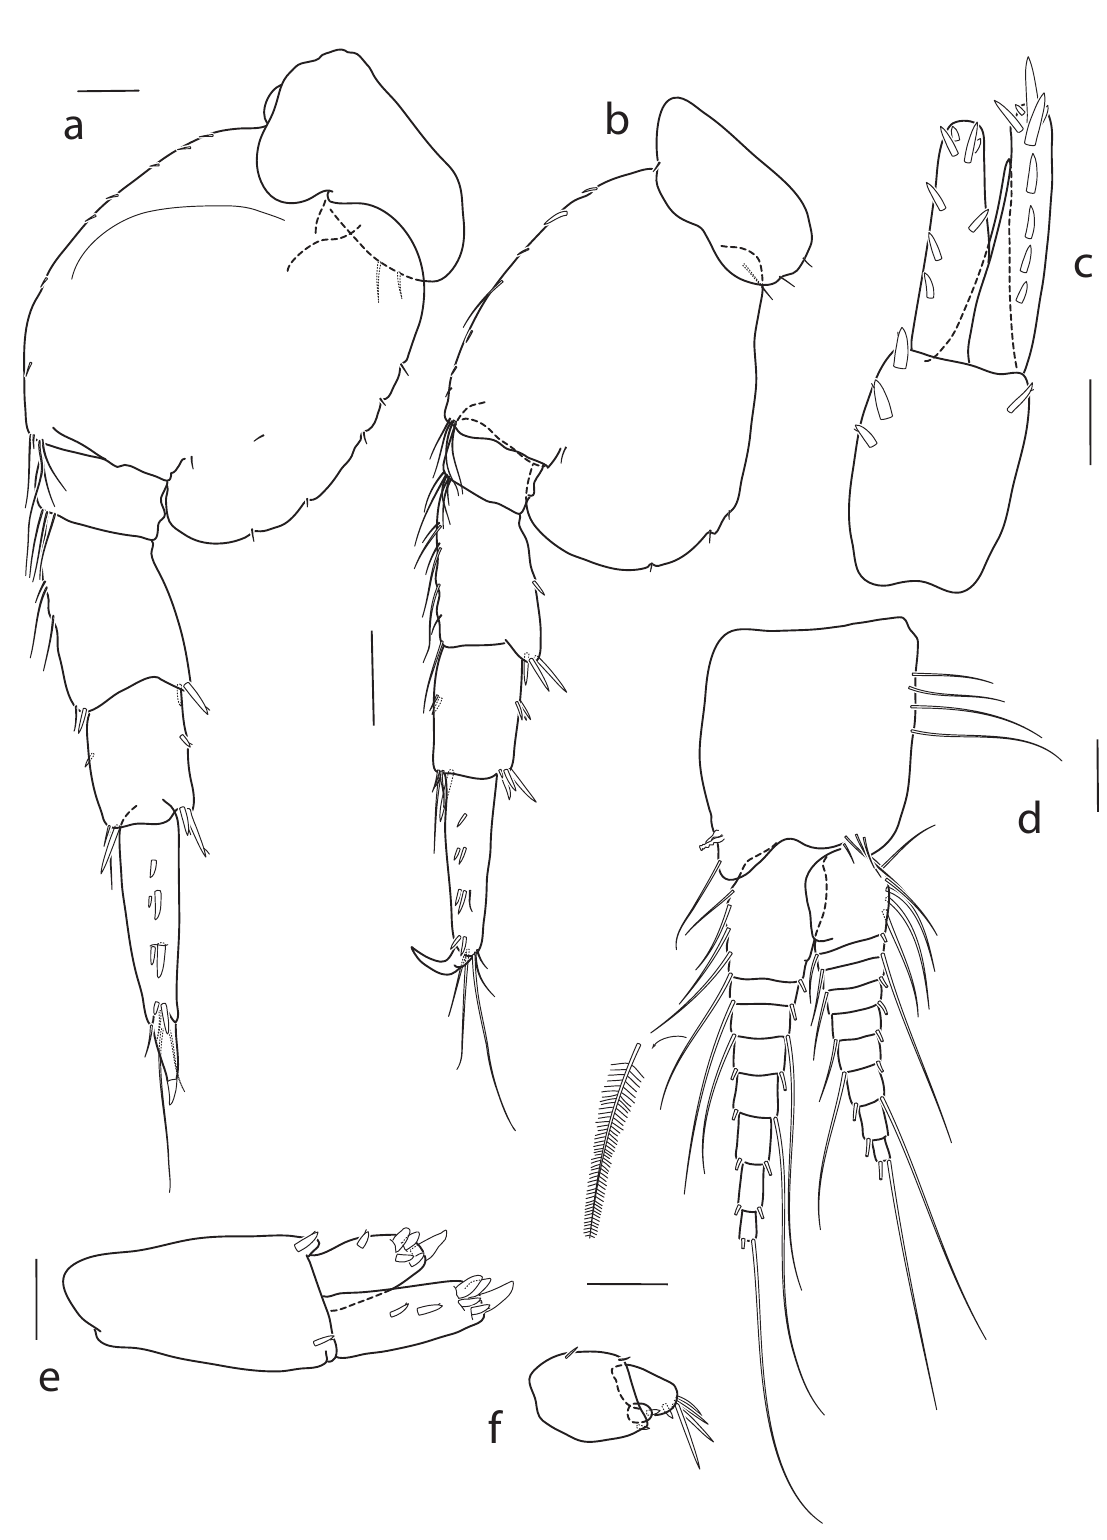
Fig. 11. Haplocheira barbimana robusta K.H. Barnard, 1932, ♂, 4.2 mm (ZMB 34098). a . Pereopod 6. b . Pereopod 7. c . Uropod 1. d . Pleopod 1. e . Uropod 2. f . Uropod 3. Scale bars: a, c–f = 100 µm; b = 200